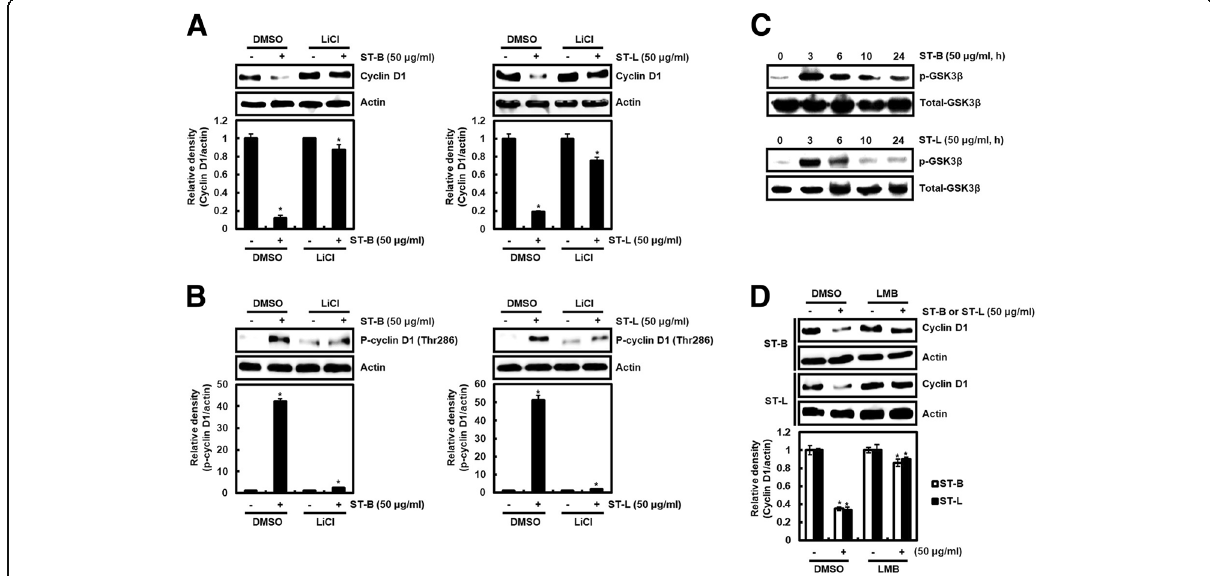
Fig. 4 Cyclin D1 degradation by STL and STB is dependent on GSK3 β . a SW480 cells were treated with LiCl (20 mM) for 2 h, and then co-treated with STL and STB for the additional 6 h. b SW480 cells were treated with LiCl (20 mM) for 2 h, and then co-treated with STL and STB for the additional 1 h. c SW480 cells were treated with STL and STB for the indicated times. d SW480 cells were treated with LMB (50 ng/ml) for 2 h, and then co-treated with STL and STB for the additional 6 h. Actin was used as loading control. * P < 0.05 compared to the cells without STL and